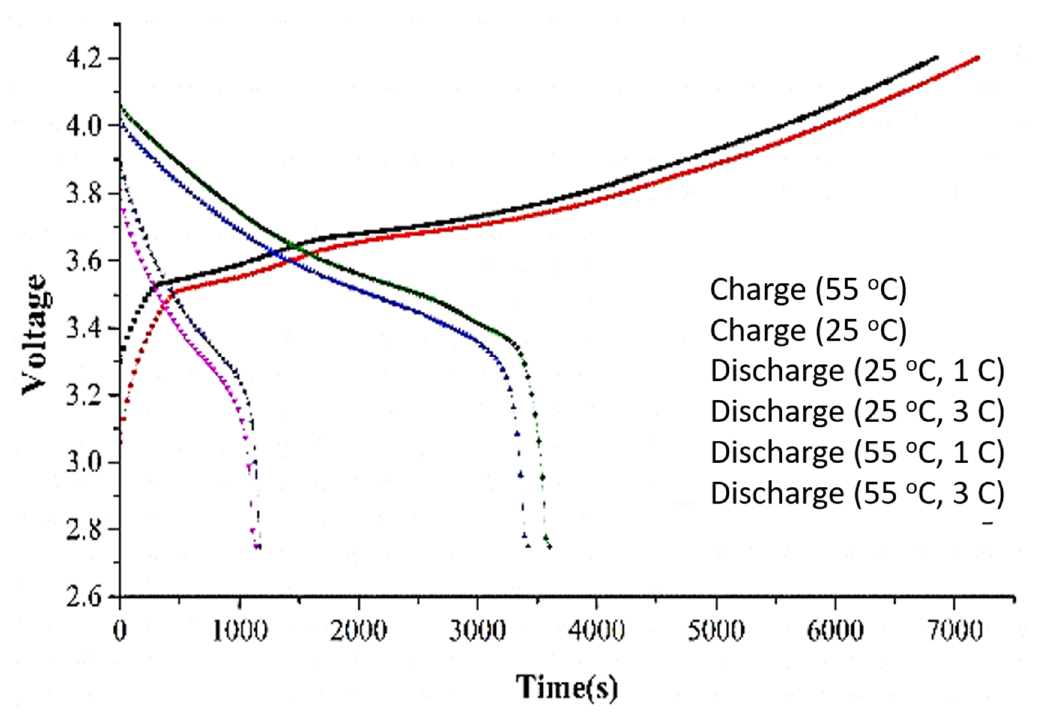
Figure 1. Variation of terminal voltage recorded during discharge period for 1 and 3 C-rate at different temperature.